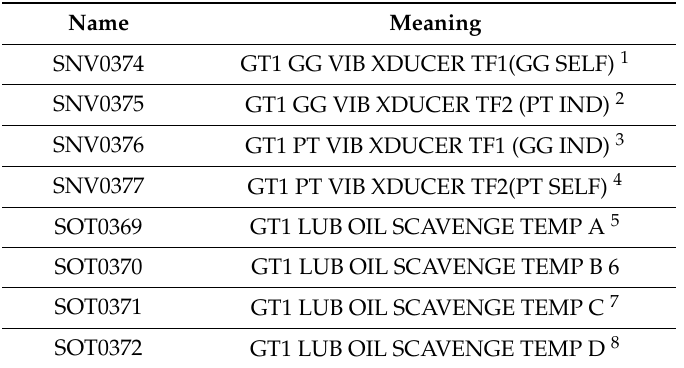
Table 2. LM2500 studied